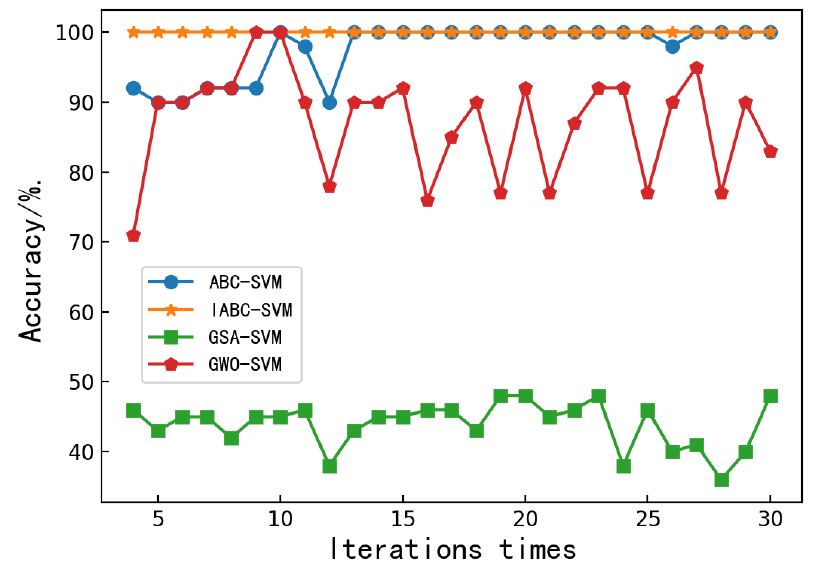
Figure 3. Relationship between classification accuracy and iteration times of the ABC-SVM, IABC-SVM, GSA-SVM and GWO-SVM models.